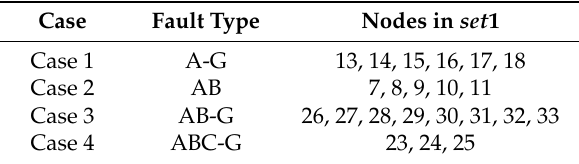
Table 1. Results of cause identification and derivation of candidate area.